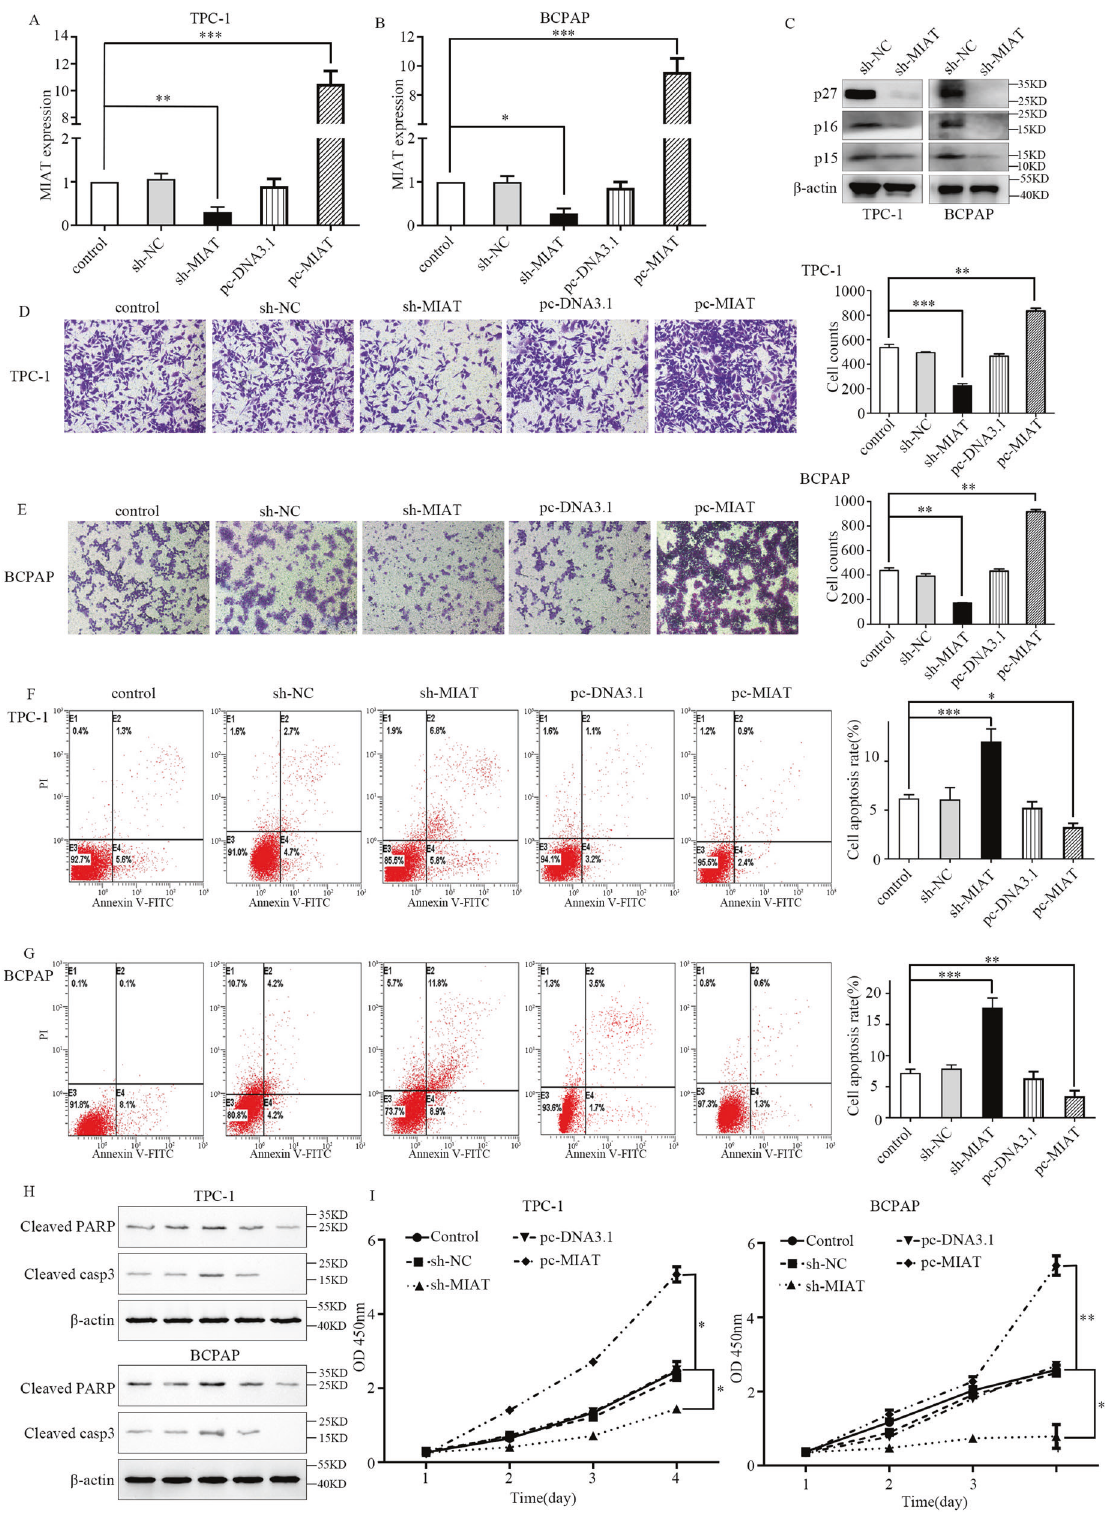
Fig. 2 MIAT promotes the proliferation, migration, and invasion of papillary thyroid cancer cells. A , B MIATexpression was reduced in TPC- 1 and BCPAP cells transfected with sh-MIAT, but increased in cells transfected with pcDNA3.1- MIAT. C The western blot of p27, p16, and p15. D , E The migratory abilities of TPC-1 and BCPAP cells were determined using transwell assay. F , G The apoptosis rate stained and analyzed by fl ow cytometry of TPC-1 and BCPAP cells were increased when MIAT were inhibited. E2, early apoptotic cells; E4, terminal apoptotic cells. The Y axis represents the apoptosis rate (E2 + E4). H The western blot of apoptosis-related protein including cleaved PARP and cleaved casp3 in TPC- 1 and BCPAP cells. I TPC-1 and BCPAP cells were transfected with sh-NC/sh-MIAT or pcDNA3.1/pcDNA3.1- MIAT, cell viability was analyzed by CCK-8 assay. * P < 0.05, ** P < 0.01, *** P < 0.001 compared with control cells, n.s. non-signi fi cant, using two-tailed t -test